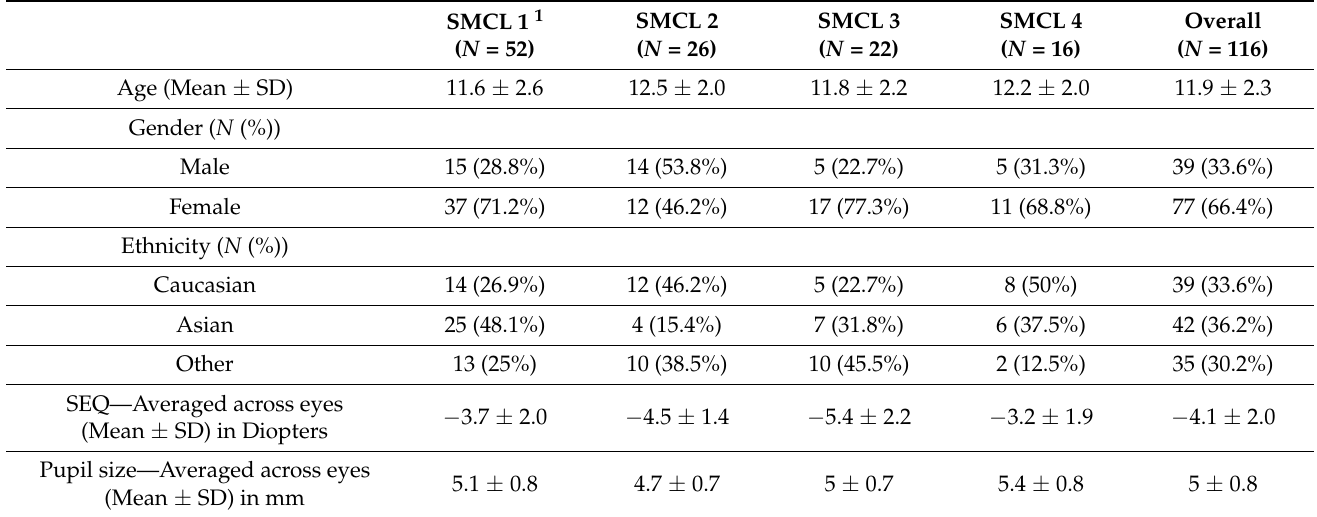
Table 5. Background statistics for the soft multifocal contact lens (SMCL) groups at